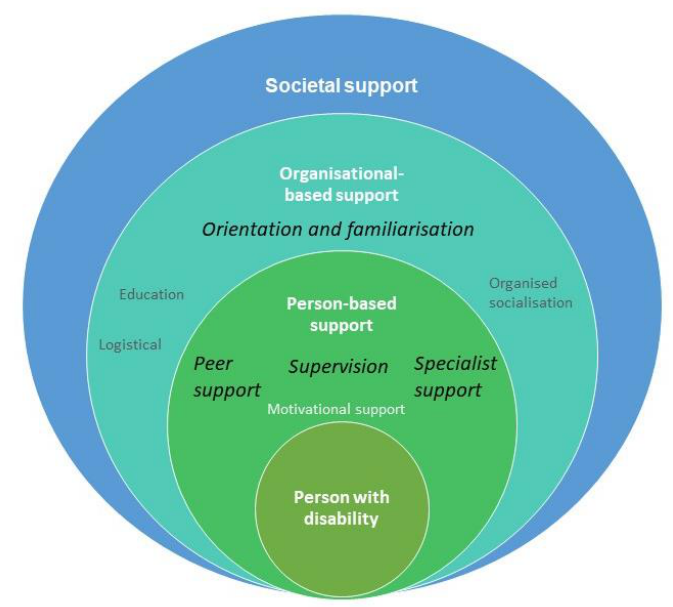
Figure 2. Mapping social supports to the socio-ecological model. The most common person- and organisational-based supports are highlighted in italics.